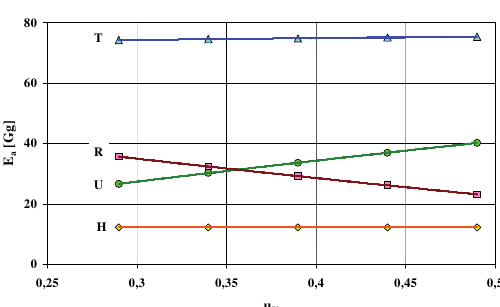
Fig. 3. Dependence of the national annual emission of nitrogen oxides from passenger cars upon the road length travelled under the following model traffic conditions: U – urban, R – rural, H – on highways and expressways and T – under all conditions